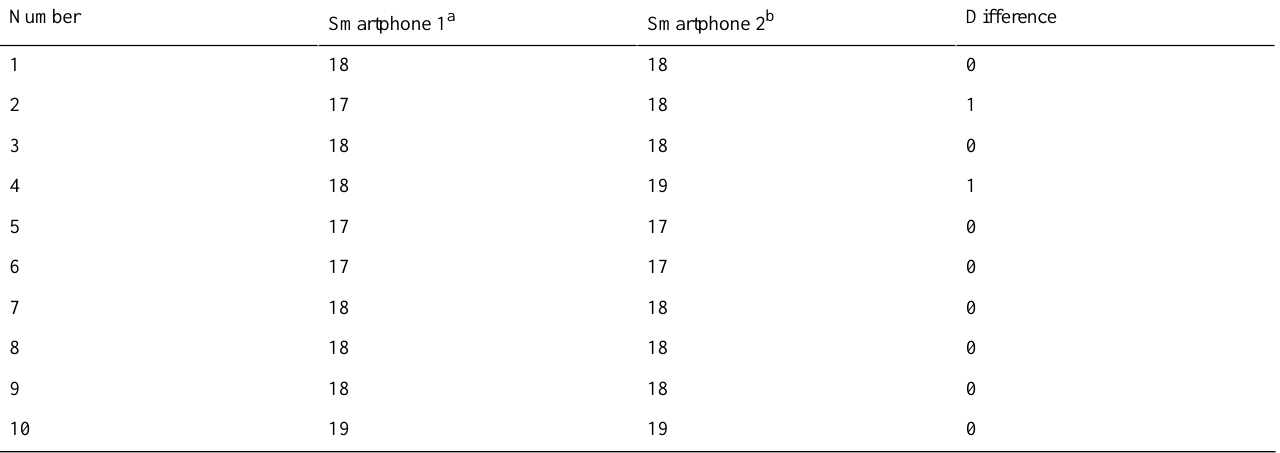
Table 5. Results of respiration rate estimation by